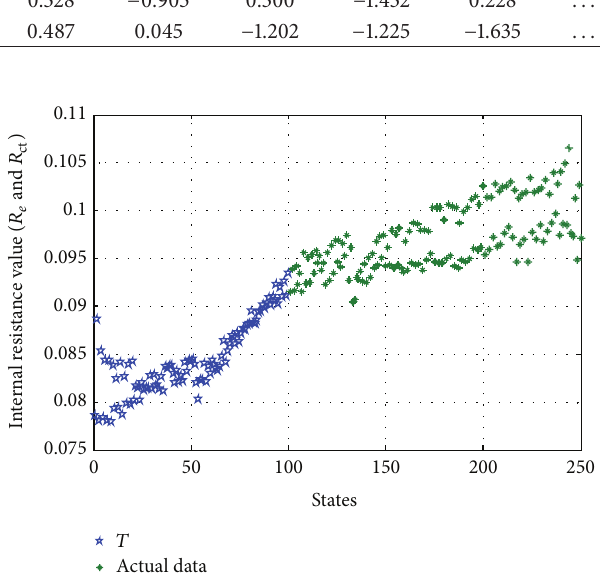
Figure4:Selectionoftrainingdata 𝑇 fromtheactualin-orbittelem-